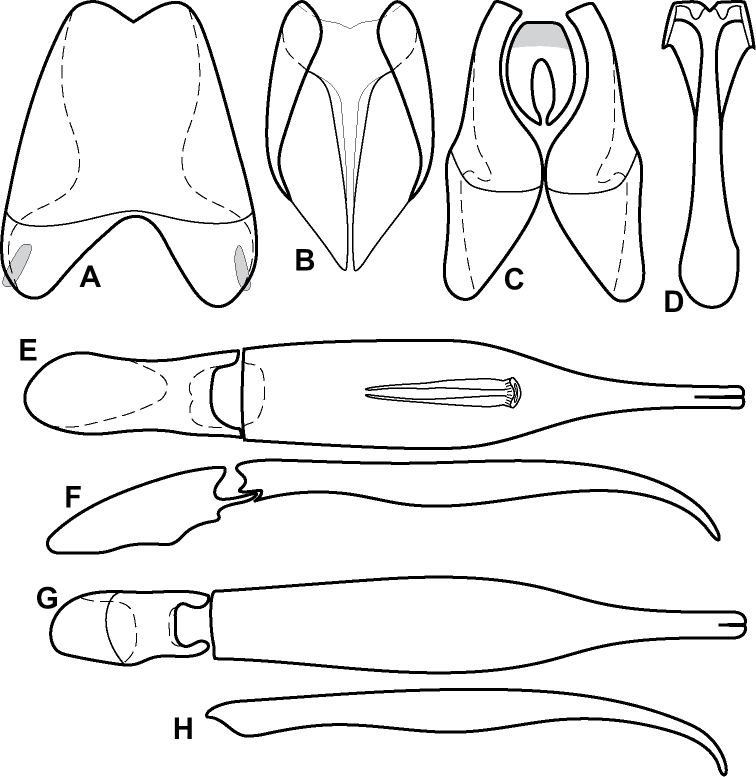
Male genitalia A–FPhelister
amazoniae: A tergite 8 B sternite 8 C tergites 9 & 10 D sternite 9 E aedeagus, dorsal F aedeagus, lateral G, HP.
arcuatus (outlines only, to contrast with E and F): G aedeagus, dorsal H tegmen, lateral.